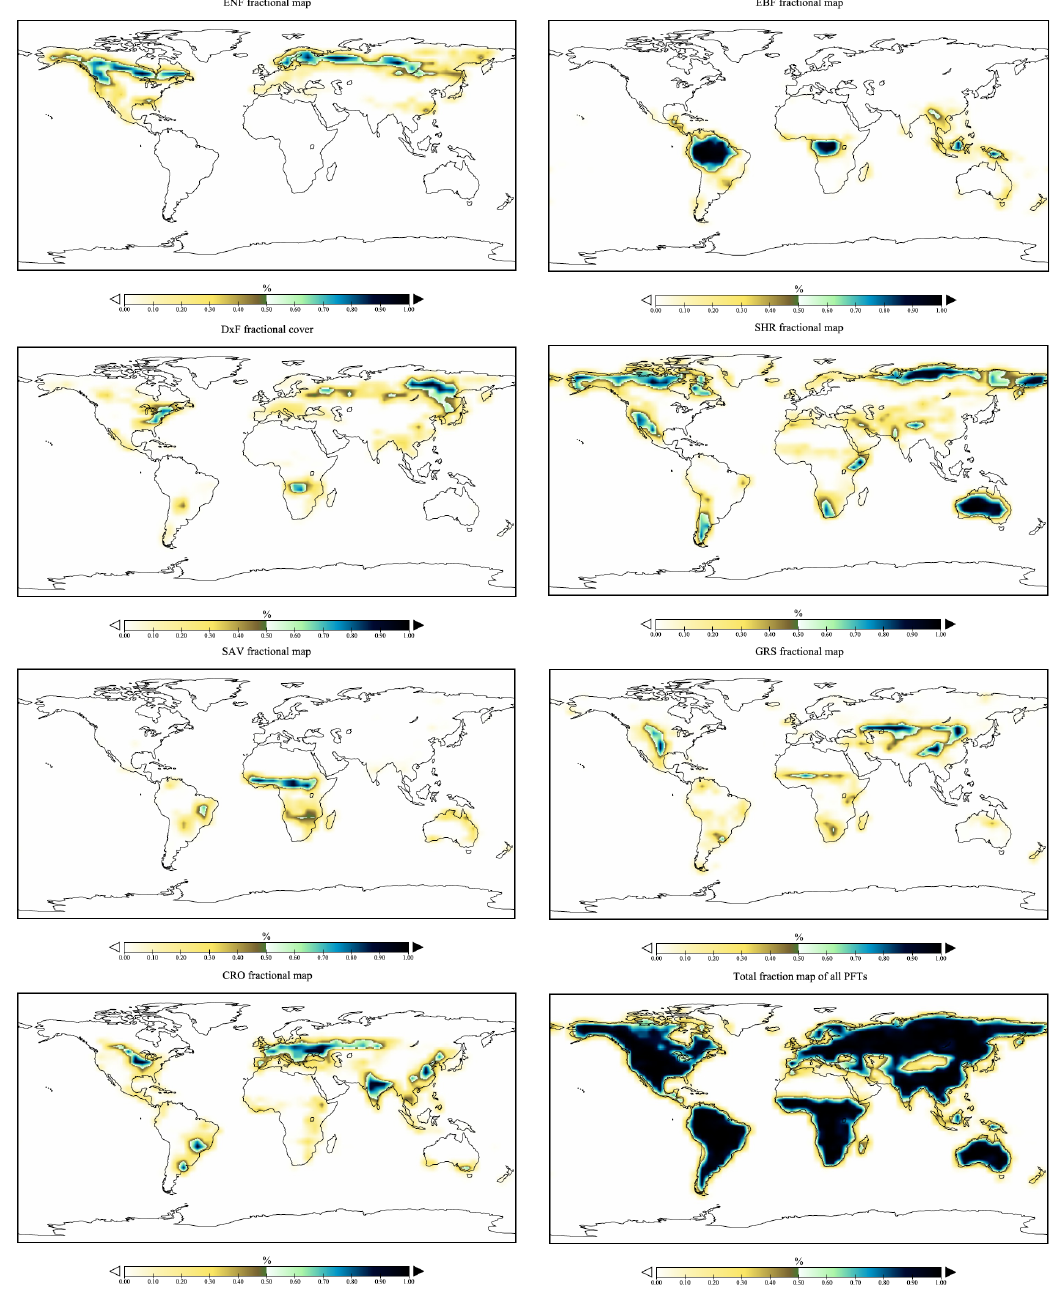
Fig. 2. Fractional cover map for each Plant Function Type PFT with a spatial resolution of 4 ◦ latitude × 5 ◦ longitude. The total fractional cover of PFTs is shown in the lower right